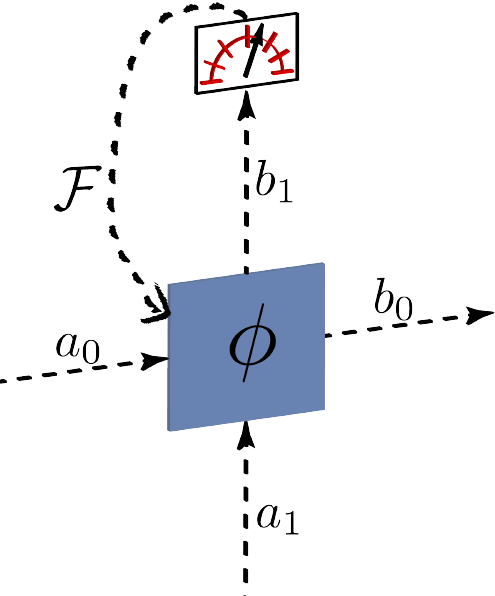
Figure 1. Graphical representation of a photonic quantum memristor. This consists of a beam splitter with tunable reflectivity, a measurement scheme, and a classical feedback system F